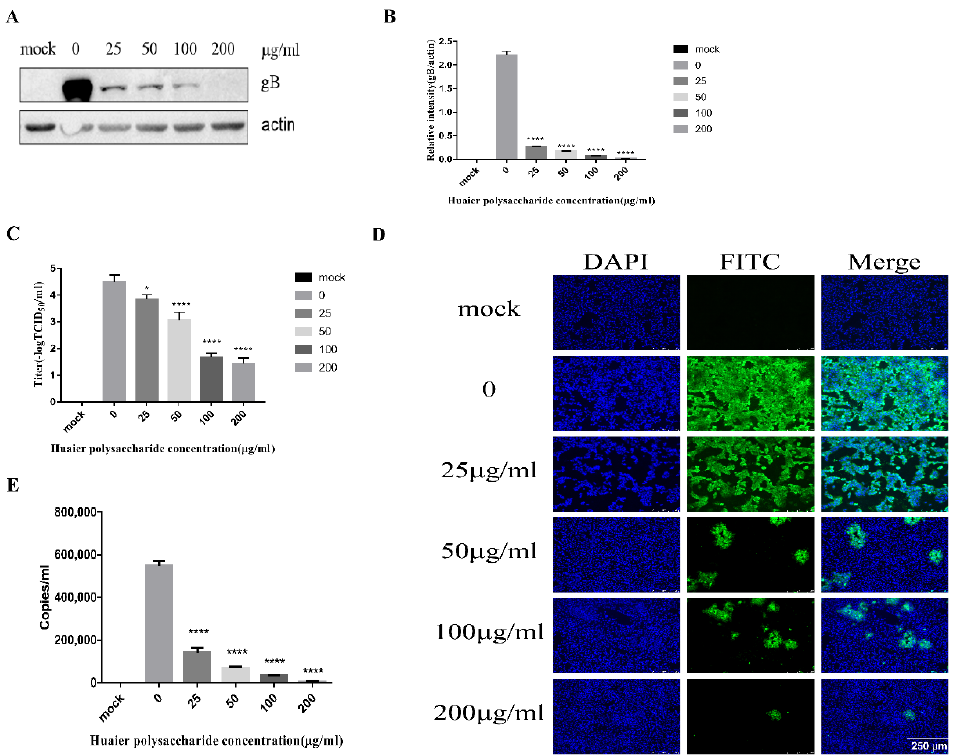
Figure 4. Huaier polysaccharide attenuates PRV XJ5 adsorption. PK15 cells were treated according to the method described in Section 2.3.4. ( A ) At 24 h.p.i., PRV gB and actin protein expression were analyzed through the Western blot assay. ( B ) The intensity band ratio of intracellular gB to actin. The intensities of protein bands were quantified using Image J. ( C ) The viral titers were evaluated through TCID 50 assay. ( D ) Infected PRV XJ5 cells were observed through IFA. ( E ) The virus DNA copies were observed through qRT-PCR after cells were washed with PBS to remove unadsorbed virus. * p = 0.0219, **** p < 0.0001. Data are shown as mean ± SD based on three independent experi- ments.